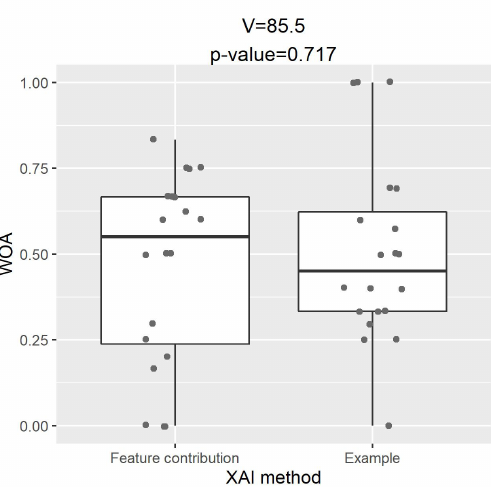
Figure 9. WOA for feature contribution and example for participants who preferred explanation by feature